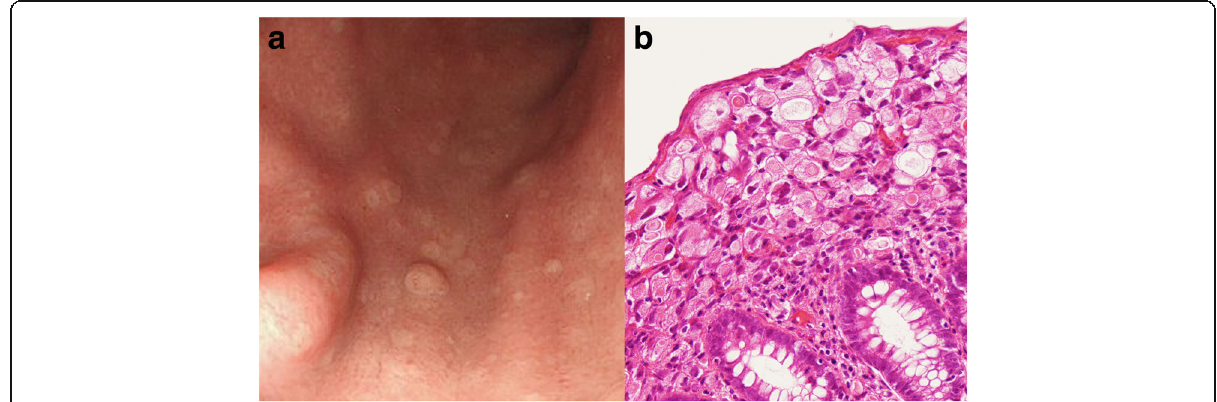
Fig. 4 Multiple metastatic gastric polyps. Gastrointestinal fiberscopy revealed multiple small white elevated polyps in the stomach ( a ), which had not been seen at the time of the initial diagnosis of recurrent disease of the colon. Pathological findings ( b , HE, ×200) confirmed signet-ring cell